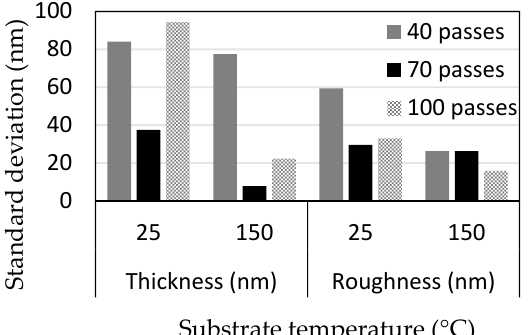
Coatings 2017 , 7 , 42 13 of 16 capable of better photon absorption, considering that the bandgap of the perovskite films is suitable for the absorption of photons in the visible range. Figure 11d is a picture of the fabricated film (5 × 5 cm 2 ), made using the optimum conditions of 100 spray passes deposited on the hotplate kept at 150 °C, using a perovskite solution concentration of 10 wt.%. The raster movement of the spray nozzle is Figure 10. Standard deviation of the roughness and thickness data of perovskite films fabricated by also illustrated schematically on this picture. This spray-on film is semitransparent and thus has the Figure 10. Standard deviation of the roughness and thickness data of perovskite films fabricated by various spray passes on the substrates kept at 25 and 150 ◦ C. High substrate temperature improves capability to be used as a second absorber layer to make tandem perovskite–copper indium gallium reproducibility of the data. various spray passes on the substrates kept at 25 and 150 °C. High substrate temperature improves diselenide (CIGS) or perovskite–silicon solar cells. reproducibility of the data.